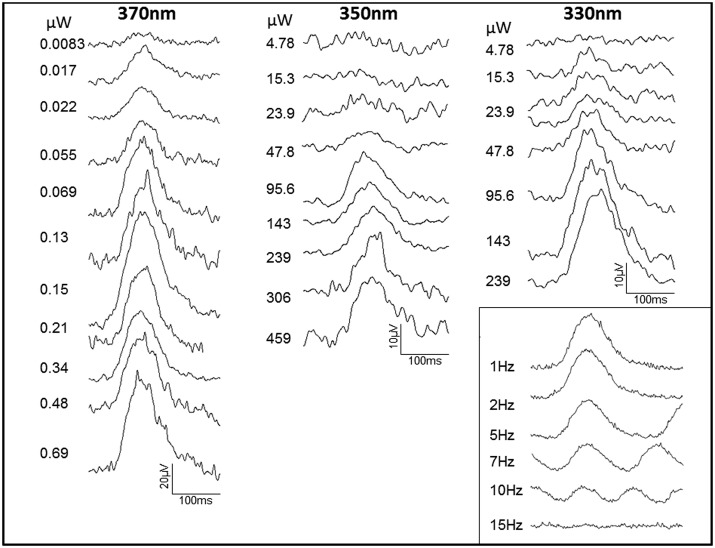
ERGs recorded to UV stimuli at 330 nm, 350 nm and 370 nm to increasing (top to bottom) stimulus intensity. ERGs at 330 nm and 350 nm are similar in amplitude. ERGs at 370 nm require less energy to elicit a response of similar amplitude. ERGs at 370 nm are double the amplitude of ERGs at 330 nm and 350 nm. Data are representative for all animals. Insert: ERGs to UV stimuli (370 nm) at increasing temporal frequencies (top to bottom). Responses are clear from 1 to 10 Hz but undetectable at 15 Hz. Similar data were obtained from two animals. Rod mediated responses do not extend beyond 15-18 Hz (Hecht and Shlaer, 1936: Kelly, 1974). Hence, responses here were limited to rod function.